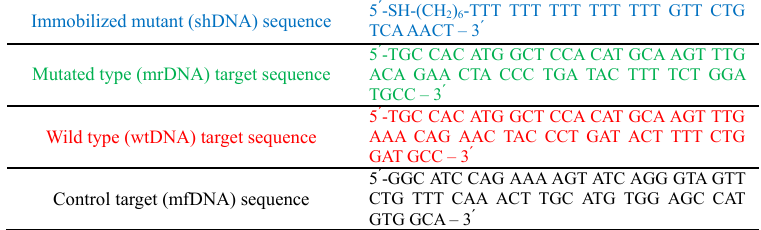
Table 1 Sequence orientation of adenine (A), thymine (T), guanine (G), and cytosine (C) sequence in BRCA1 (916delTT). Immobilized mutant (shDNA) sequence